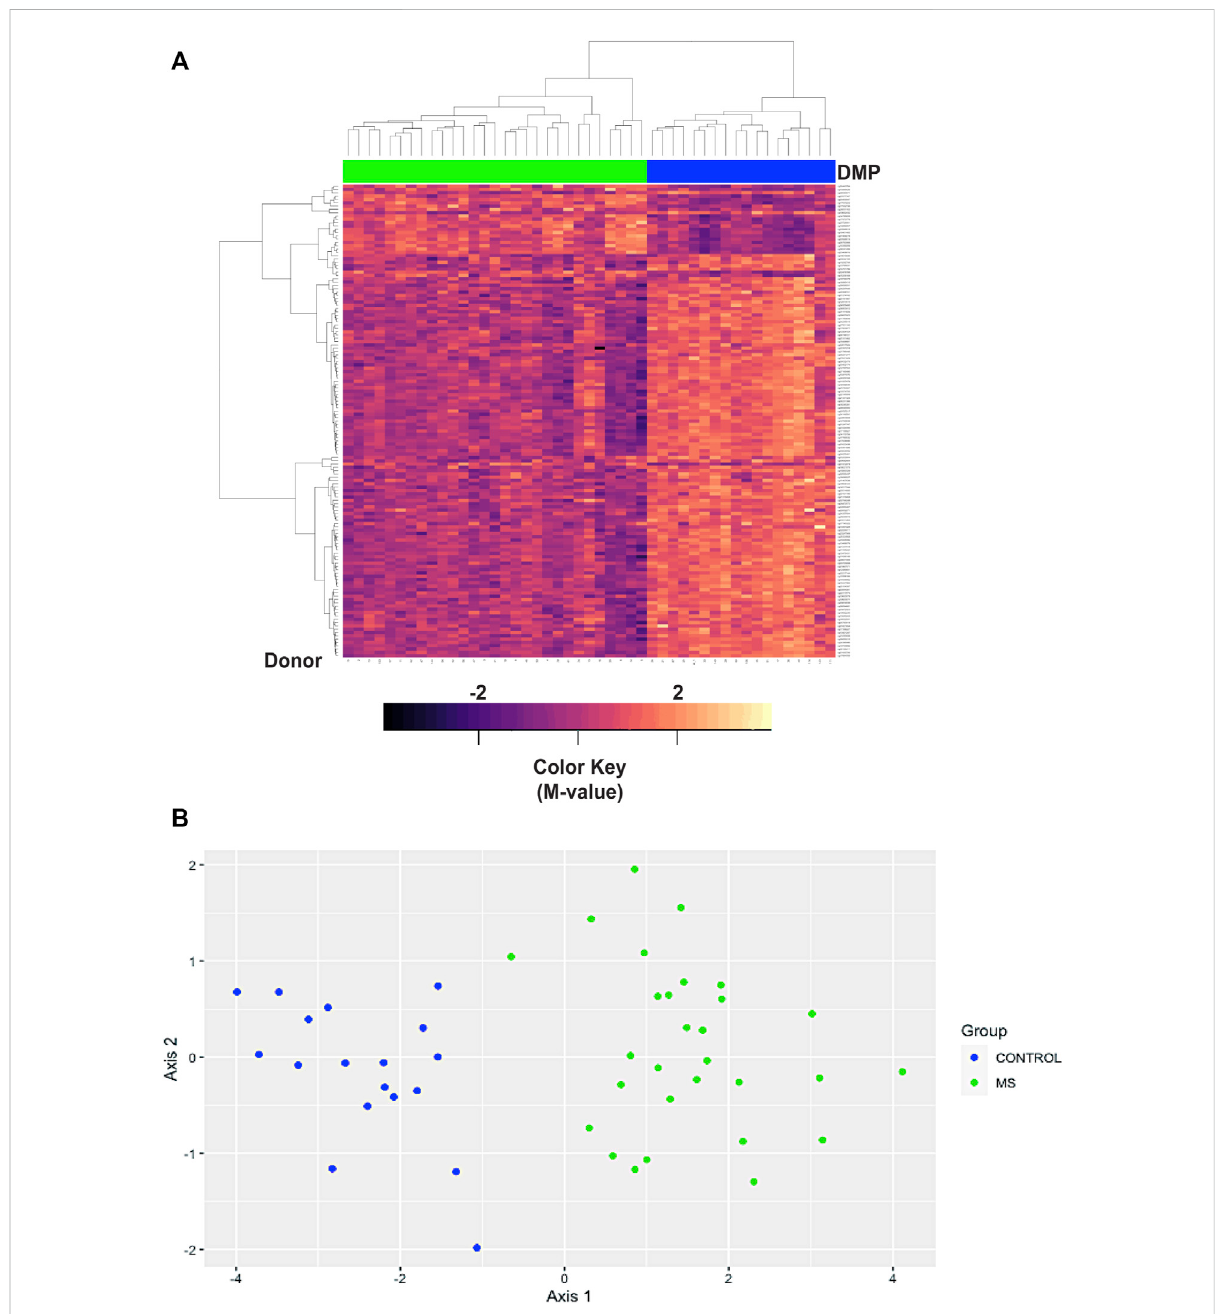
FIGURE 4 Hierarchal clustering and multi-dimensional scaling (MDS) analysis of differentially methylated regions associated with MS. (A) Hierarchal clustering analysis was performedon 147differentiallymethylated lociwithin thetop 10differentiallymethylated regions (Supplementary Table S15). In the heatmap, MS donors are designated by green, and controls by blue at the top of the heatmap. Blue/purple designates relative demethylation and orange/red increased methylation at a speci fi c CpG site. Gene regions included: ARID5B, BAZ2B, CDK2AP1, CLU, CTSZ, RAB34, RABGAP1, SFRP2, TNFSF12-TNFSF-13, and WBP1L. (B) MDS analysis was performed on the same data set and showed a goodness of fi t (GOF) of